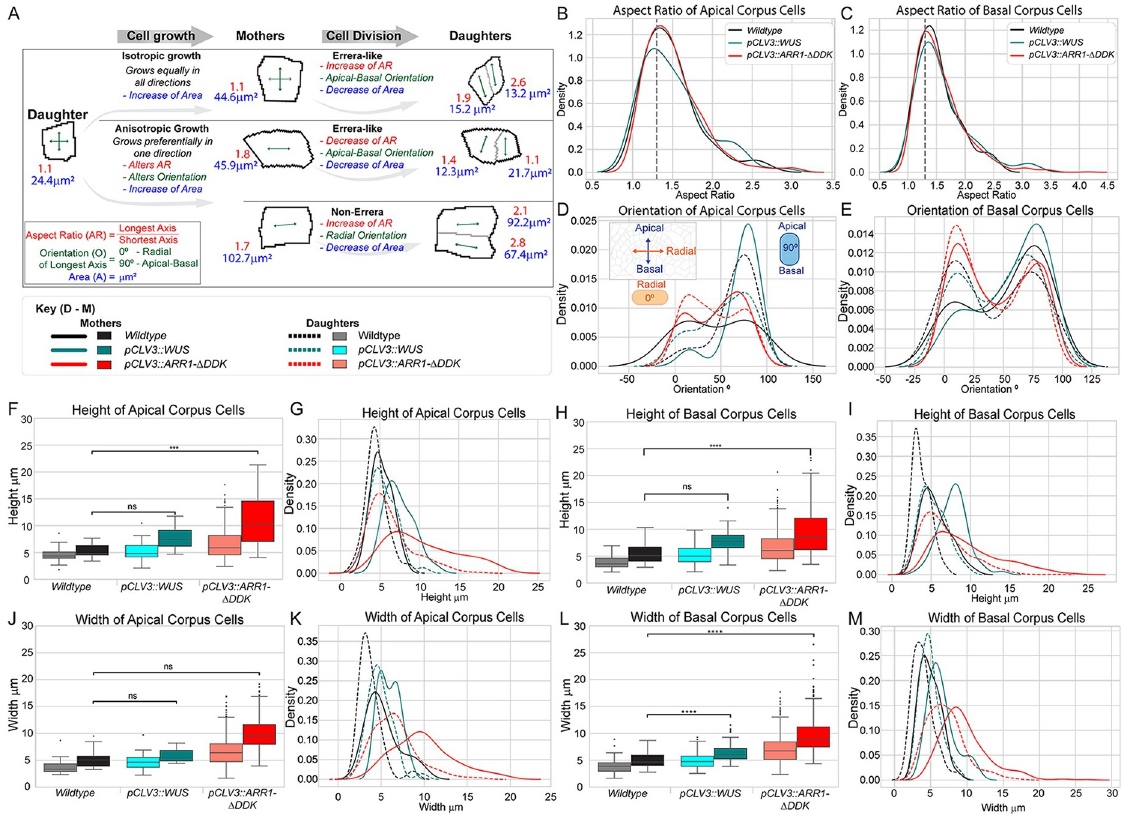
Fig 9. Ectopic misexpression of WUS and CK signaling influence the direction of anisotropic expansion of cells. (A) Patterns of anisotropic cell expansion have distinct outcomes on the aspect ratios and orientations of mother and new daughter cells. (B-C) Distributions of cell aspect ratios in wildtype (black), ectopic misexpression of WUS (teal), and ectopic misexpression of CK (red) experiments. (D-E) Distributions of mother and daughter cell orientations in wildtype (black, grey), ectopic misexpression of WUS (teal, cyan) and ectopic misexpression of CK (red, salmon) experiments are shown separately for all cells with aspect ratios above 1.3. Cells were segregated into mother and daughter cells by area. Distributions of mother and daughter cell (F,G) heights and (H,I) widths are shown separately for wildtype and ectopic misexpression experiments. Additional analysis of L1 and loss of functions mutants included in S6